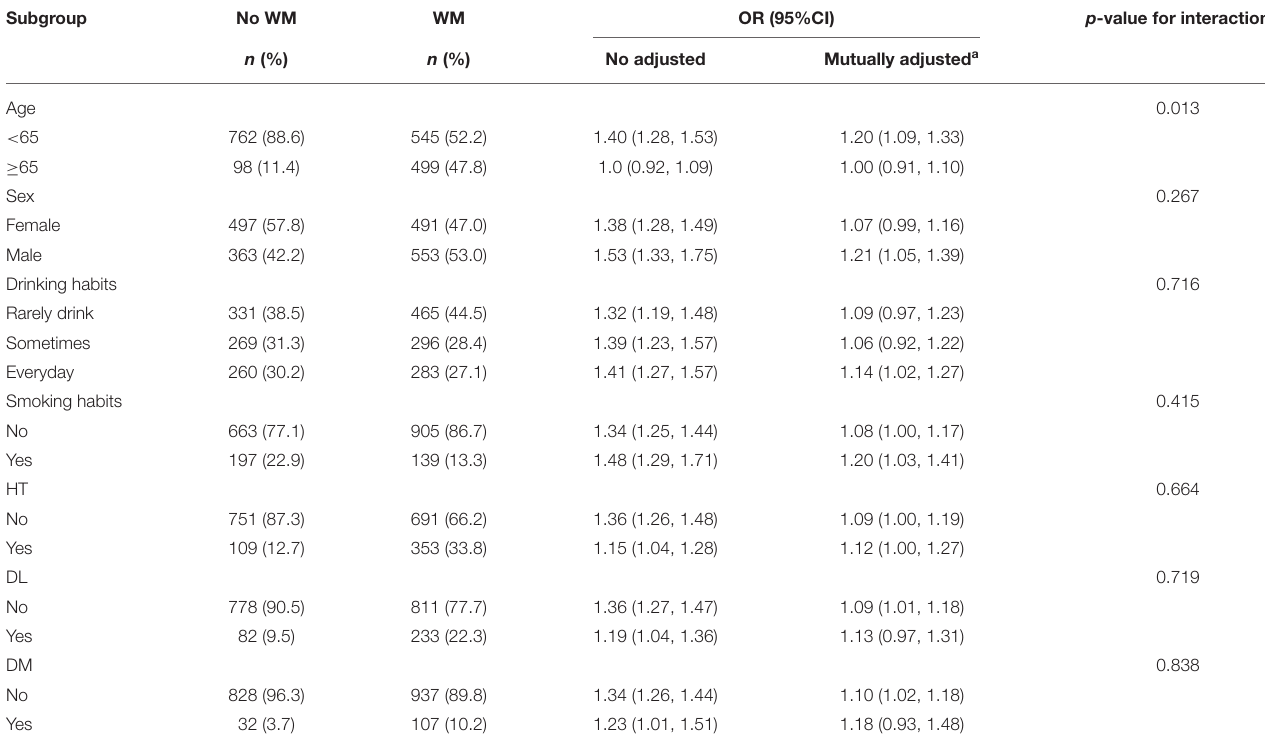
TABLE 3 | Association between PS and White matter hyperintensity according to baseline characteristics.